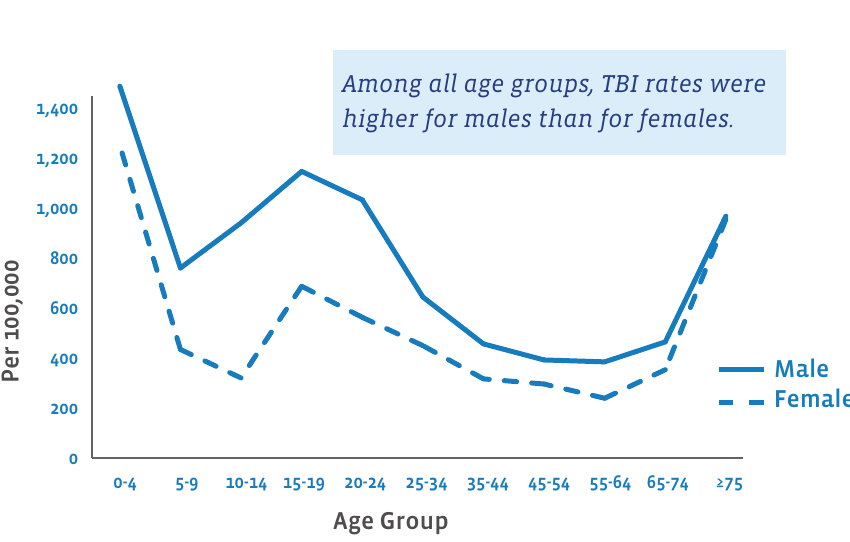
TABLE C: Estimated Average Annual Numbers of Traumatic Brain Injury–Related Emergency Department Visits, Hospitalizations, and Deaths, by Sex, United States,